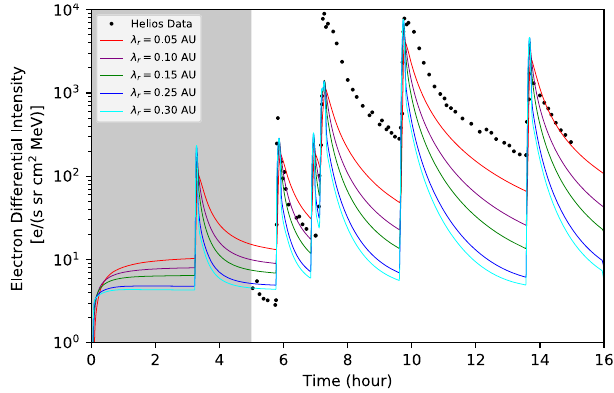
Fig. 3. Simulated temporal evolution of the differential intensity for a range of radial mean free path ( k r ) values as indicated in the legend. Note that the model takes ~5 h to settle into a quasi-steady state (indicated by the grey shading) if initialised with constant SEP injection at the